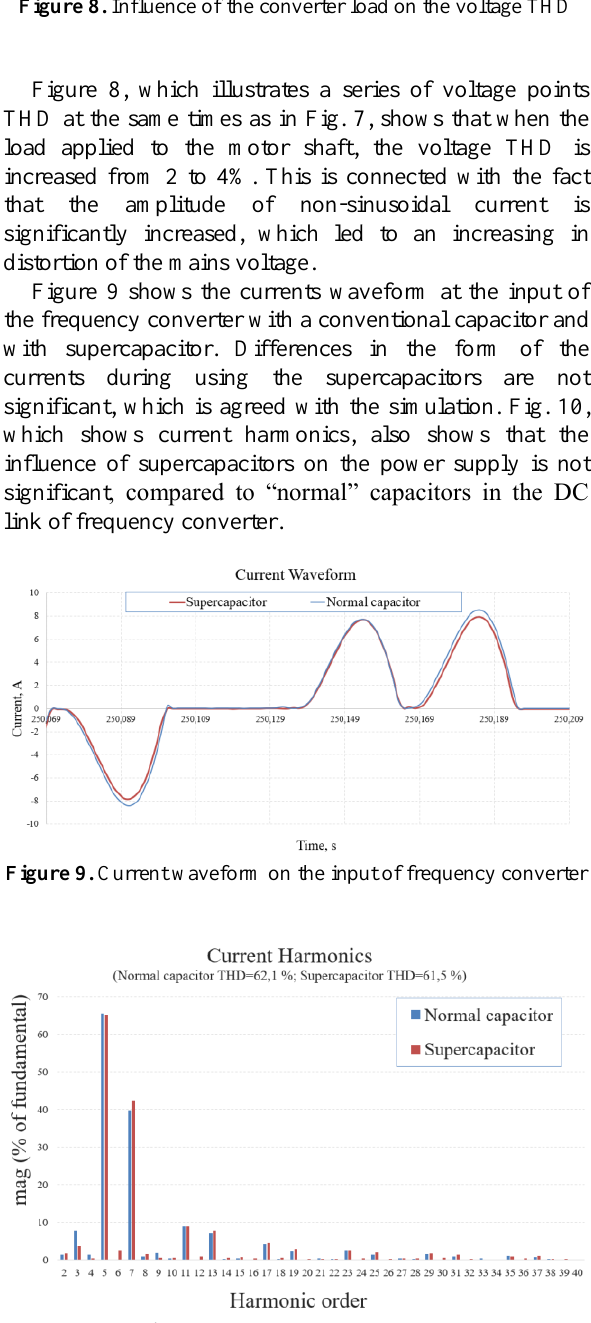
Figure 10. Input current